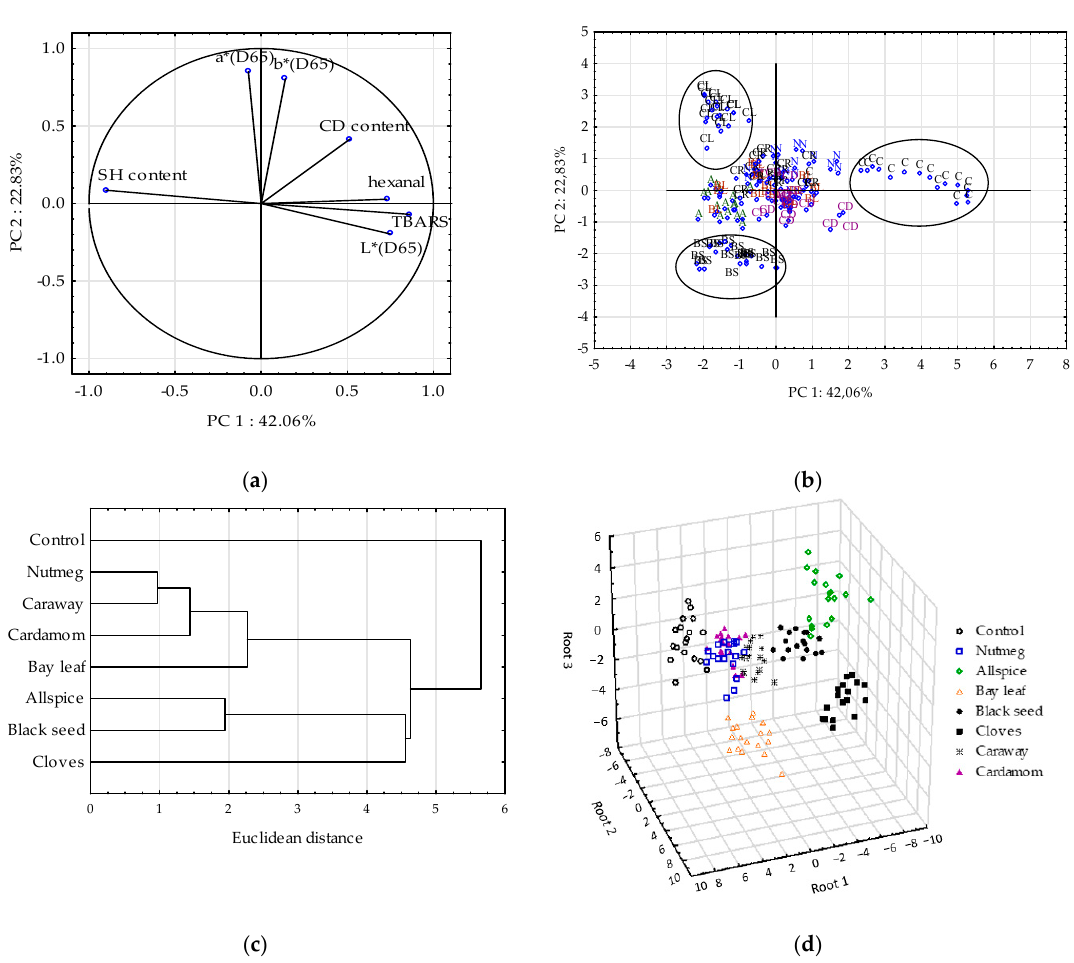
Figure 6. Multivariate analyses: ( a ) Projections of the variables (TBARS—thiobarbituric acid reagent substances, CD—conjugated diene content, SH—thiol group content, hexanal content, L*a*b* color coordinates) onto the factor plane defined by principal components (PC1 and PC2), ( b ) Projections of the scores (samples of raw ground chicken) onto the factor plane (PC1 vs PC2), samples: C—control sample, samples with treatments: A—allspice, BL—bay leaf, BS—black seed, CD—cardamom, CL—cloves, CR—caraway, N—nutmeg, ( c ) Dendrogram of raw ground chicken samples according to CA of similarity, ( d ) GDA classification of raw ground chicken samples.